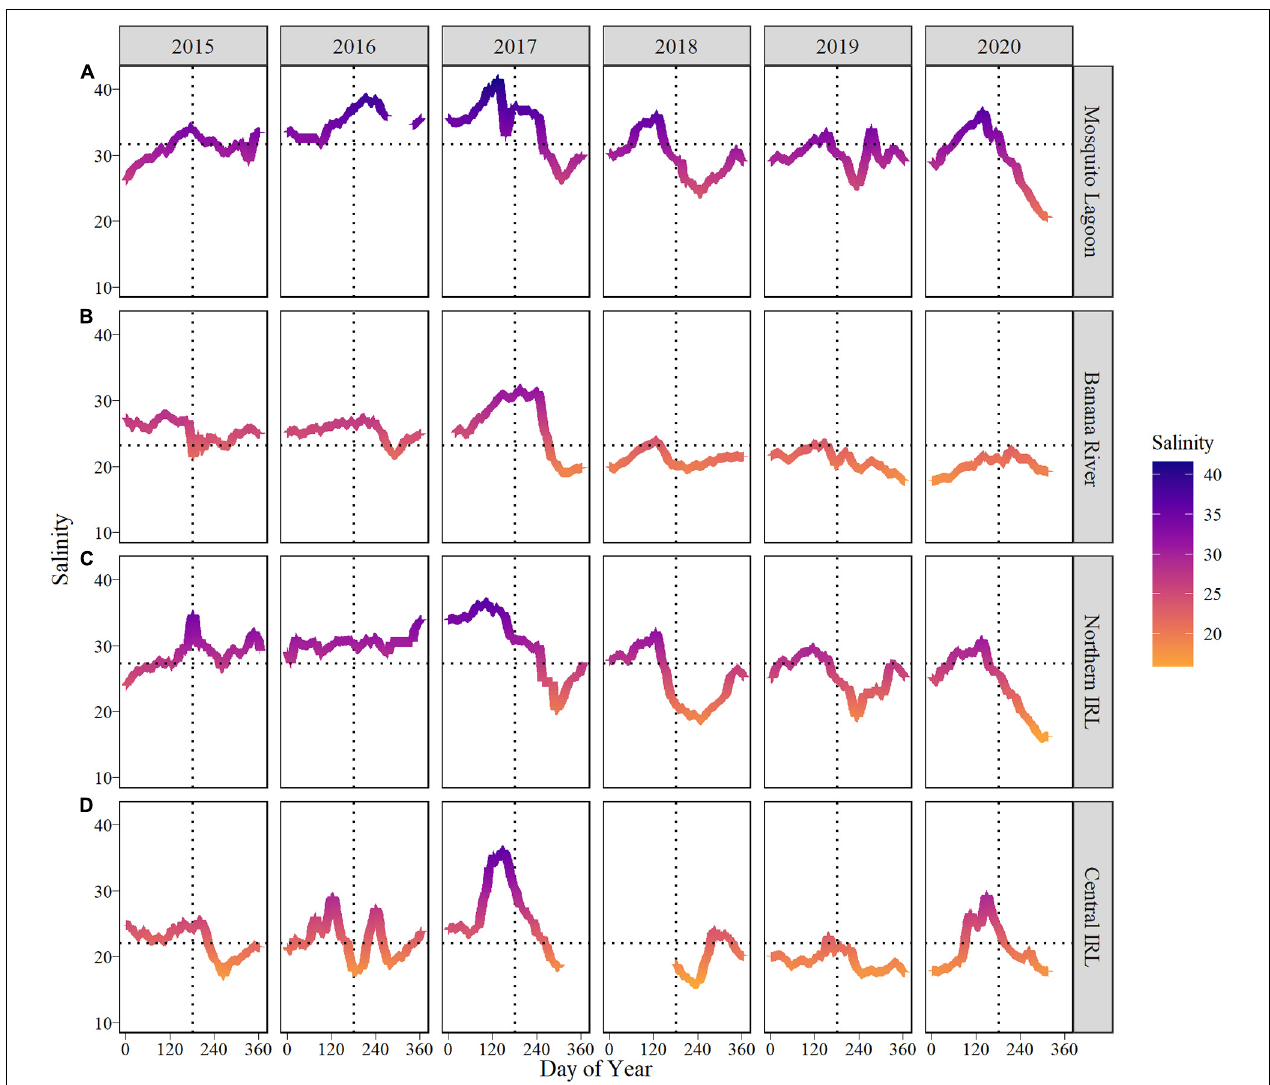
FIGURE 3 | Weekly rolling average of in situ salinity collected at SJRWMD continuous monitoring stations for (A) Mosquito Lagoon, (B) Banana River Lagoon, (C) Northern IRL, and (D) Central IRL. Line color indicates the salinity gradient of the weekly rolling average, ranging from the lowest salinities (orange) to the highest salinities (blue). The horizontal lines represent the mean daily salinity for all years for each respective basin. The vertical dotted line represents JD 182 (July 1, non-leap